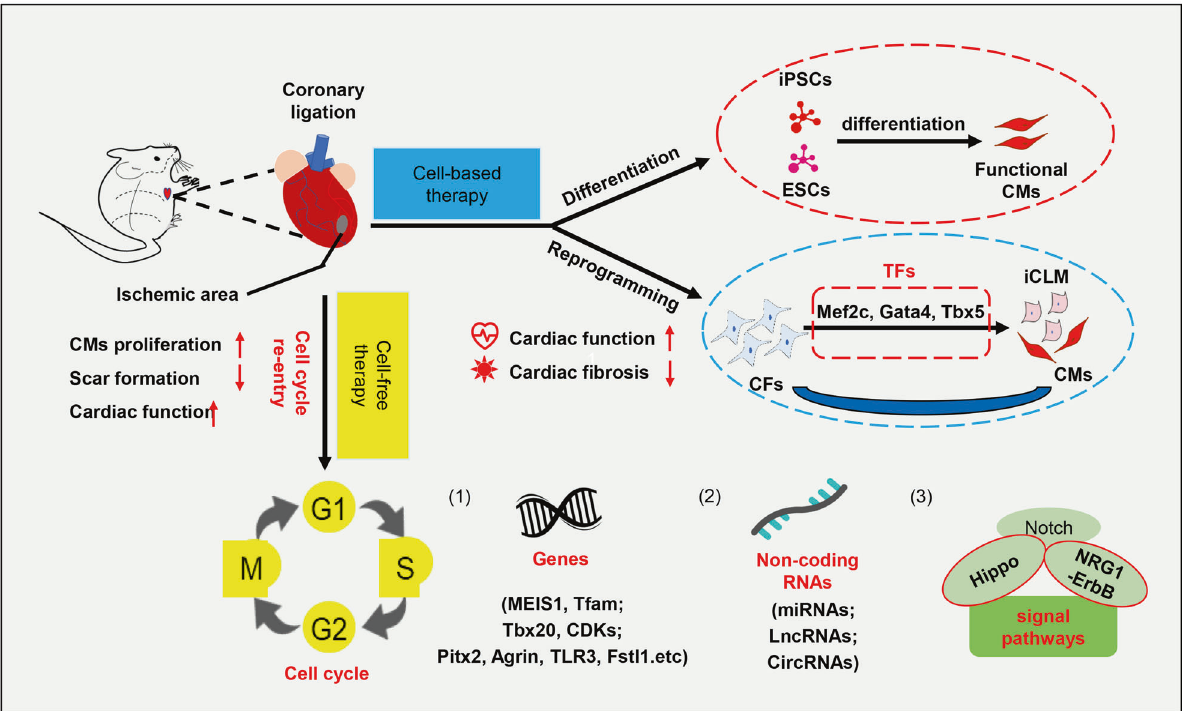
Fig. 1 Schematic diagram of cell-based therapy and cell-free therapy for heart repair and cardiac function improvement after MI. In cell-based therapies, cell differentiation and trans-differentiation are introduced. Among them, iPSC-CMs and ESC-CMs obtained through in vitro differentiation were transplanted into the infarcted heart to survive and maintain stable cardiac implants, achieve iCLM function, and ultimately improve cardiac functions. Reprogramming large amounts of CFs, also present in the heart, into cardiomyocytes is also a heart repair strategy that can achieve orthotopic cardiomyocyte supplementation. In cell-free therapy, the main entry point is the re-entry of the cell cycle. Pre-existing cardiomyocytes re-enter the cell cycle to proliferate through intervention with cyclin modulators (such as cyclin or its dependent kinases (CDKs), and genetic modi fi cation with cycle arrest modulators (such as MEIS1) and cycle promoters (such as GATA4 and Tbx20), as well as other aspects of the microenvironment (for example, Pitx2, etc). In addition, some non-coding RNAs or various signal pathways promote or hinder heart repair and cardiac regeneration by regulating the expression of critical genes. CMs cardiomyocytes, CFs cardiac fi broblasts, CircRNAs circular RNAs, ESCs embryonic stem cells, Fstl1 follistatin-like 1, iCLM induced heart-like muscle cells, iPSCs induced pluripotent stem cells, LncRNAs long non-coding RNAs, miRNAs microRNAs, Tfam transcription factor A, mitochondrial, TLR3 Toll-like receptor 3, TFs transcription factors. ↑ : upregulate; ↓ :